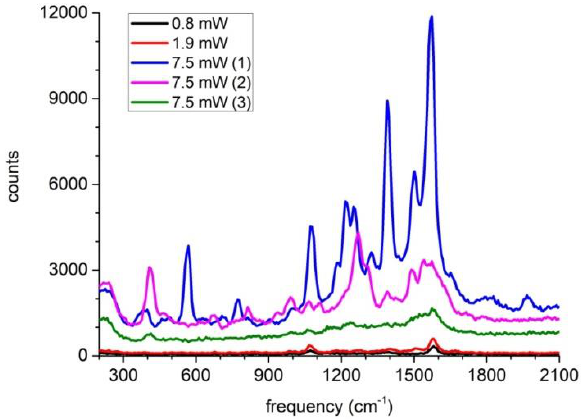
Figure 4. SERS spectra of a dimer structure measured subsequently with di ff erent laser power settings.